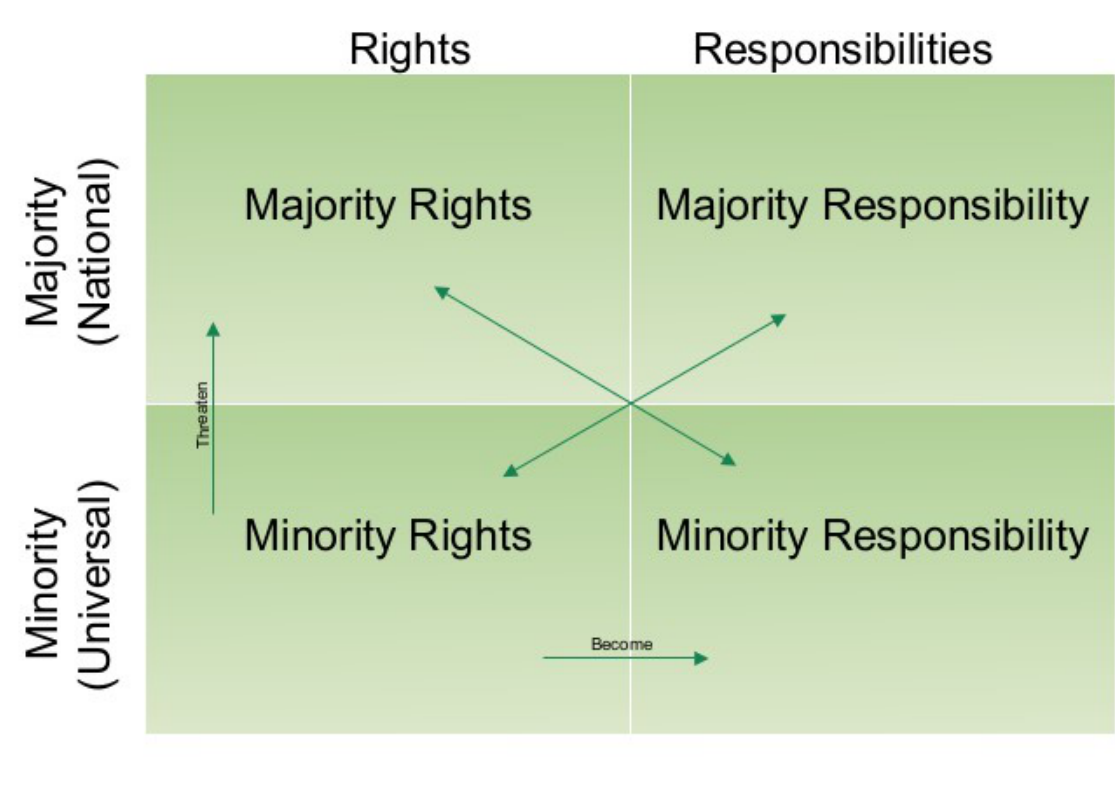
Relationships and intersections between majority and minority rights and